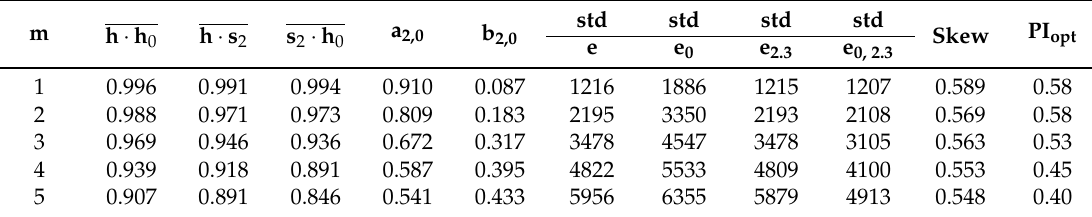
Table 2. Results from combinations of model 2.3 and persistence model. Columns 2–4 show parameters (correlation coefficients) for all error equations, column 5 and 6 are parameters for Equation (15). Column 7 lists standard deviations (std) of calibration error e = Q(i+m) ´ QF 1 (i+m). All std are given in m³/s.